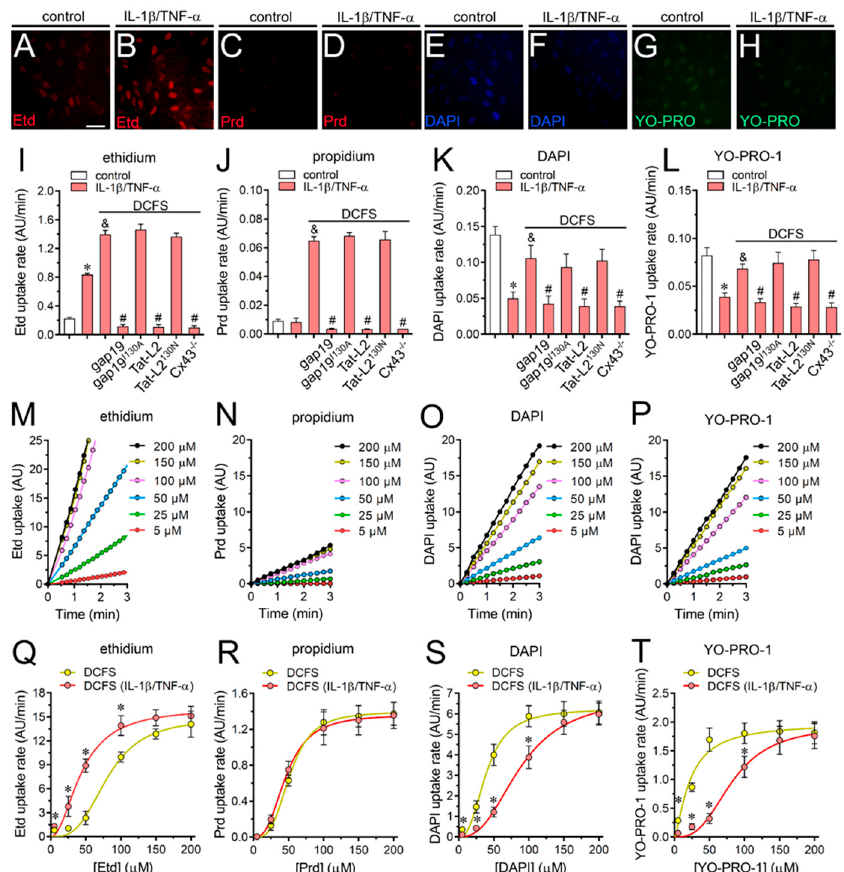
pharmacological agents vs. DFCS (two-way ANOVA followed by Tukey’s post hoc test). ( M – S ) Representative fluorescence images depicting Etd ( M , N ), Prd ( O , P ), DAPI ( Q , R ), and YO-PRO-1 ( S , T ) staining from dye uptake measurements (10 min exposure to each dye) in astrocytes exposed to DCFS alone (upper panels) or plus 100 µ M gap19 (below panels). Calibration bars: white 6 µ m; yellow: 20 µ m; and green: 40 µ m.